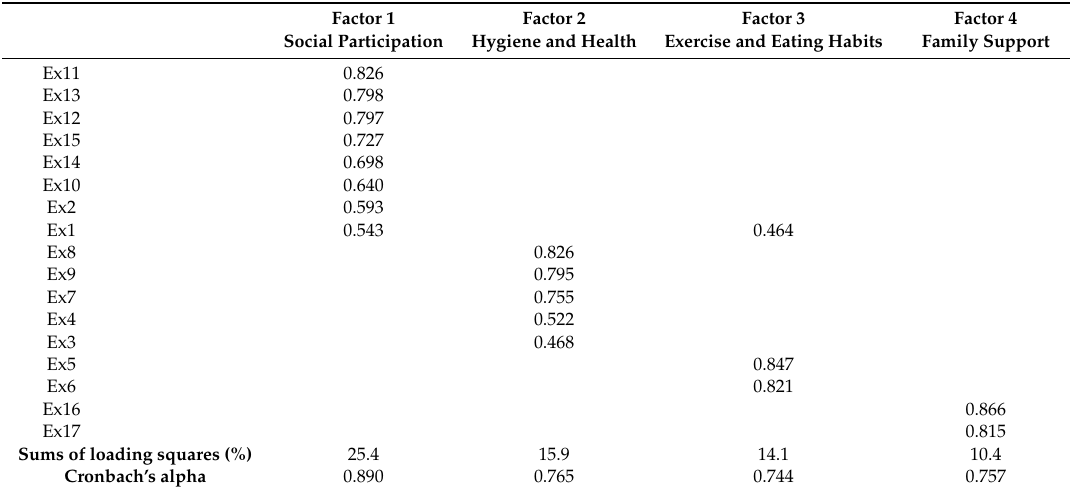
Table 3. Results of principal component